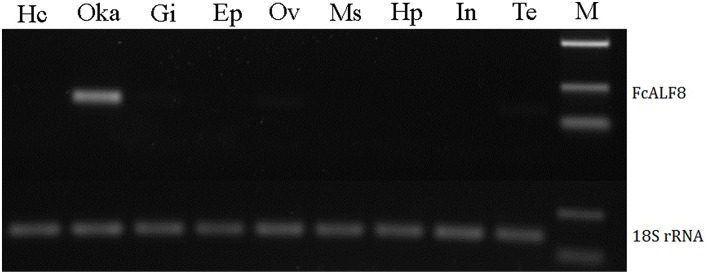
Tissue distribution of FcALF8. Hc, hemocyte; Oka, lymphoid organ; Gi, gill; Ep, epidermis; Ov, ovary; Ms, muscle; Hp, hepatopancreas; In, intestine; Te, testis; M, DL2000 marker. 18S rRNA was used as internal reference gene.